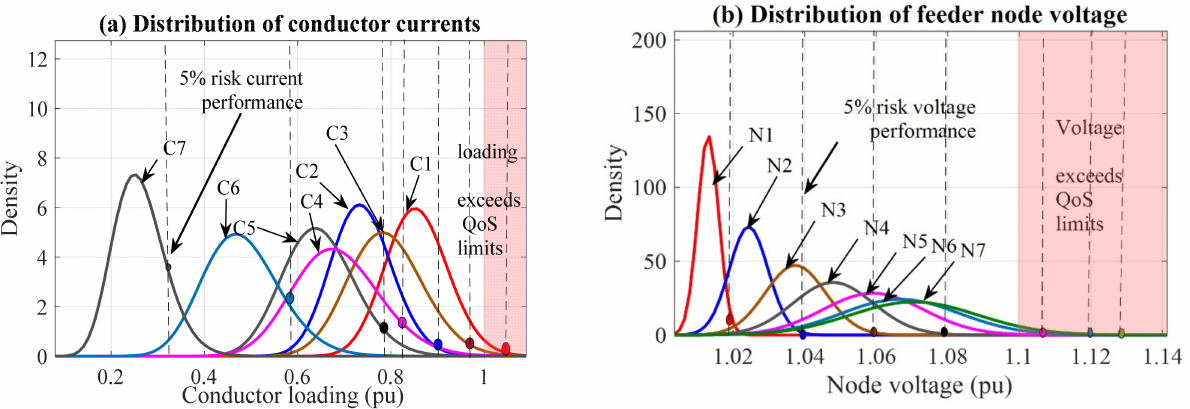
Figure 7. Probability distributions showing ( a ) conductor currents at the maximum loading impact penetration and ( b ) feeder voltages at the maximum voltage impact penetration.